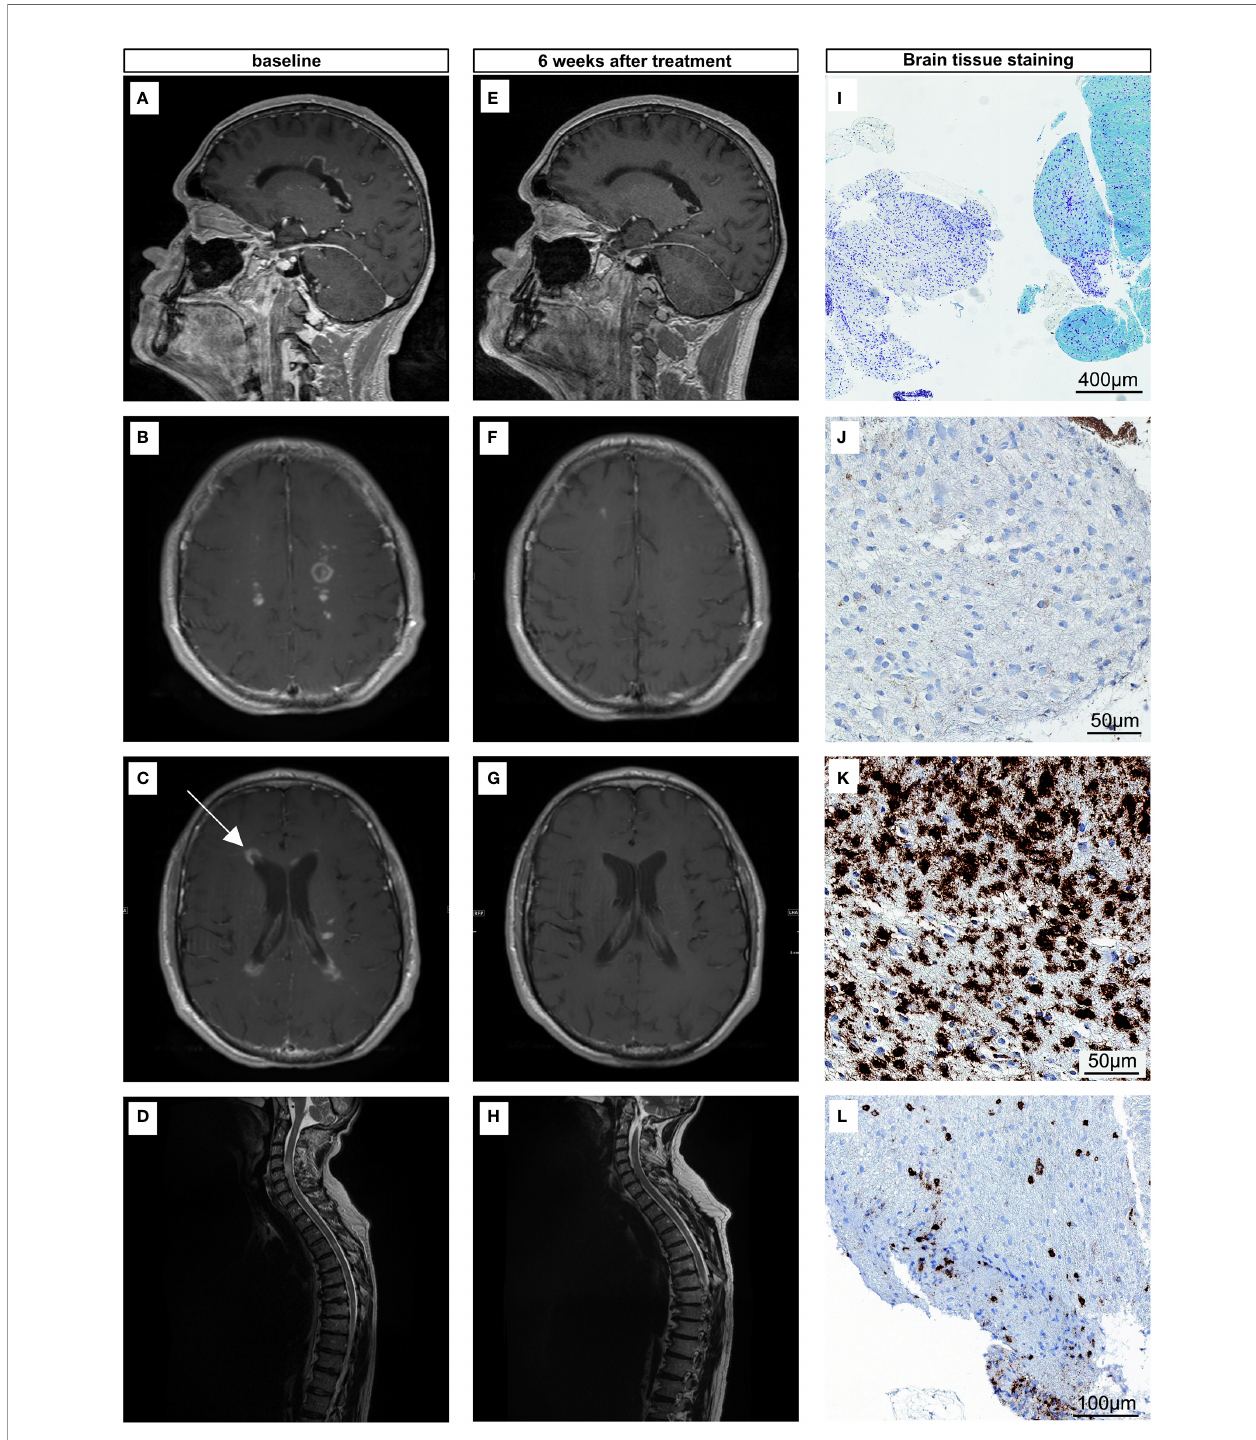
FIGURE 1 | (A – D) MR-Images of the brain and spine showing multiple periventricular, parenchymal and leptomeningeal contrast enhancements at the time of diagnosis. T1-weighted contrast-enhancement MRI sequence of the brain (A – C) and T2- weighted MRI sequence of the spine (D) . Arrow pointing to the site of biopsy (C) . (E – H) MR-Images 6 weeks after high-dose steroid treatment showing near complete remission. T1-weighted contrast-enhancement MRI sequence of the brain after steroid treatment (E – G) and T2- weighted MRI sequence of the spine after steroid treatment (H) . (I – L) Histology of the stereotactic biopsy. Demyelinated areas are shown in Klüver-Barrera staining (I) and CNP-ase staining (J) , with numerous foamy macrophages [CD68, (K) ]. Scattered CD45+ lymphocytes are present in the demyelinated areas (L)